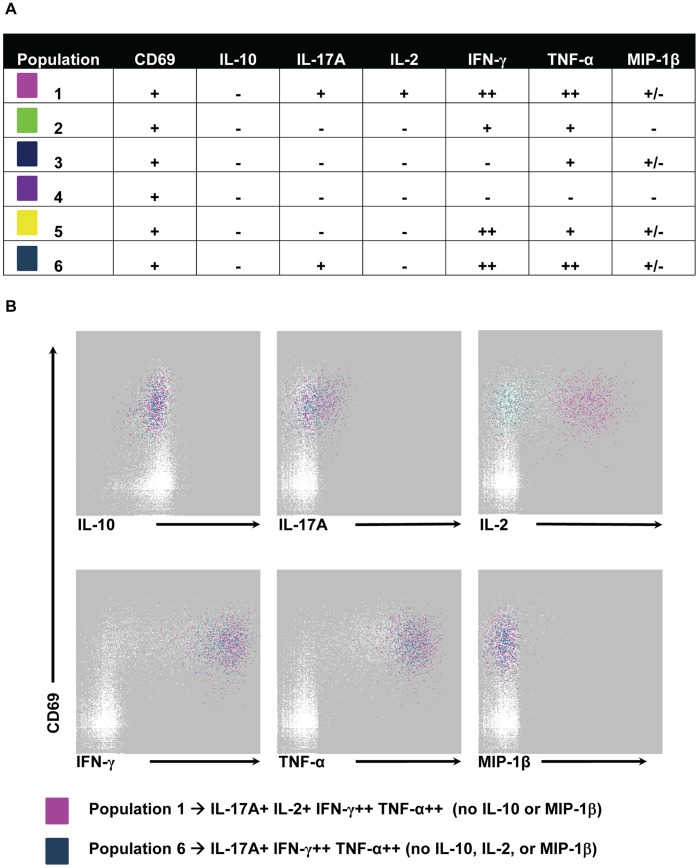
CD69+ populations identified by unsupervised FLOCK analyses.CD3+ CD8+ TEM events following S. Typhi-infected autologous B-LCL stimulation were uploaded to ImmPort for FLOCK analyses. A) Cytokine/chemokine production patterns of the 6 CD69+ populations identified by FLOCK. B) Histograms showing FLOCK of representative volunteer 53 s at day 10 post immunization with the IL-17A+ populations highlighted (population 1- pink and population 6- aqua).